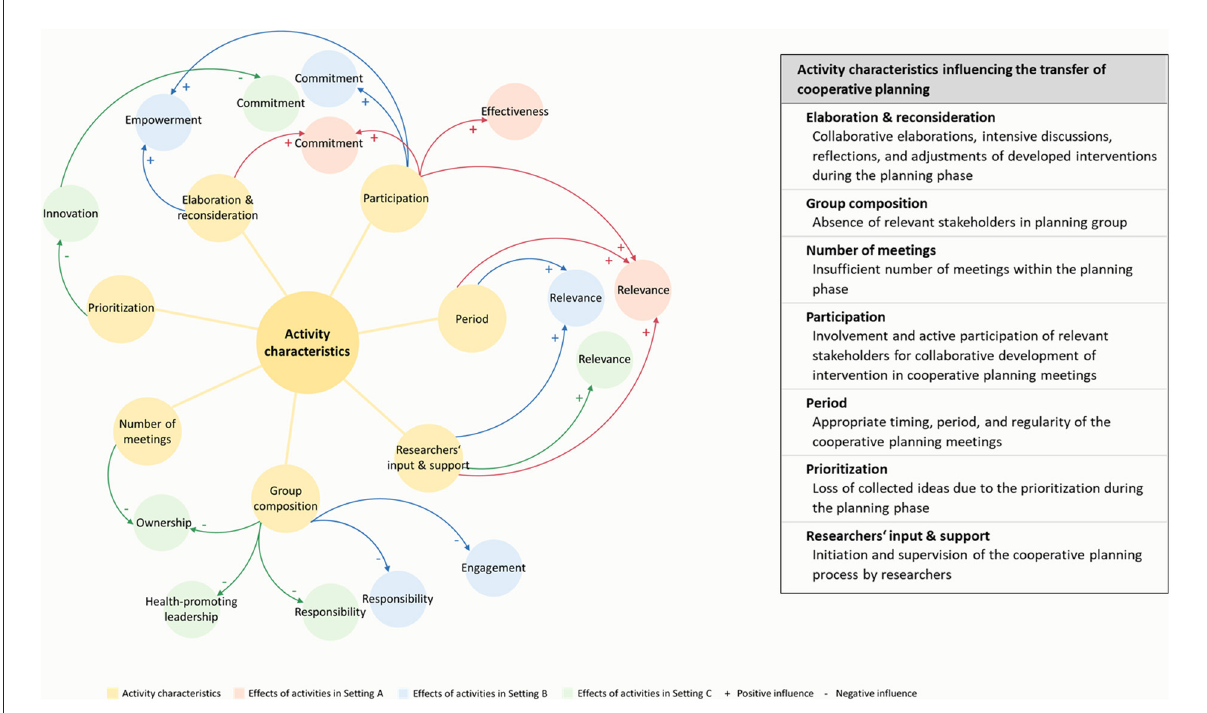
FIGURE3 Activity characteristics influencing the transfer of cooperative planning identified through qualitative content